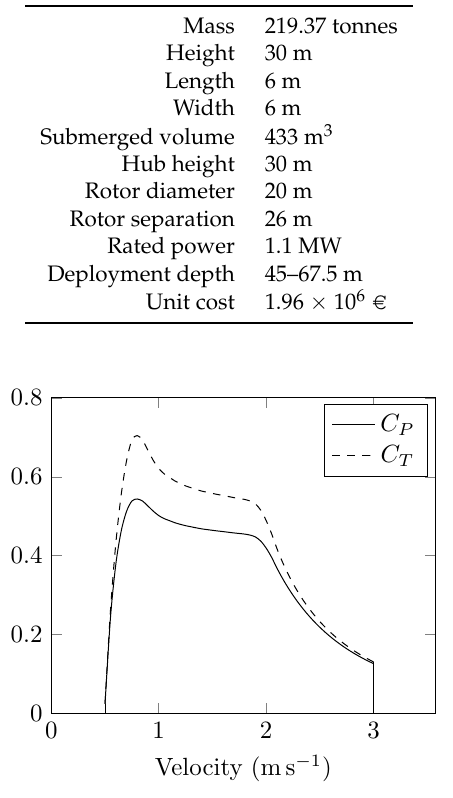
Figure 12. Coefficients of power ( C P ) and thrust ( C T ), with respect to current velocity magnitude, for the RM1 device